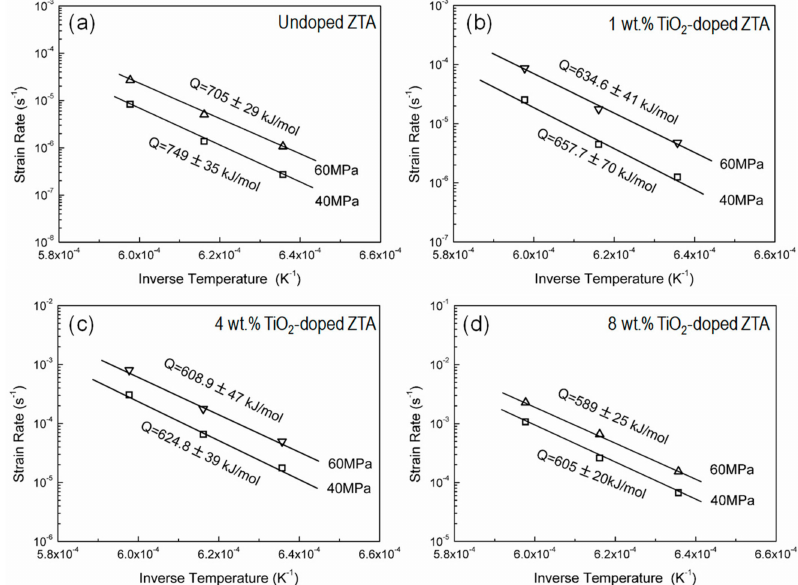
Figure 5. Relationships between the strain rate and reciprocal absolute temperature for the ZTA ceramics doped with di ff erent amounts of TiO 2 : ( a ) 0T, ( b ) 1T, ( c ) 4T and ( d )